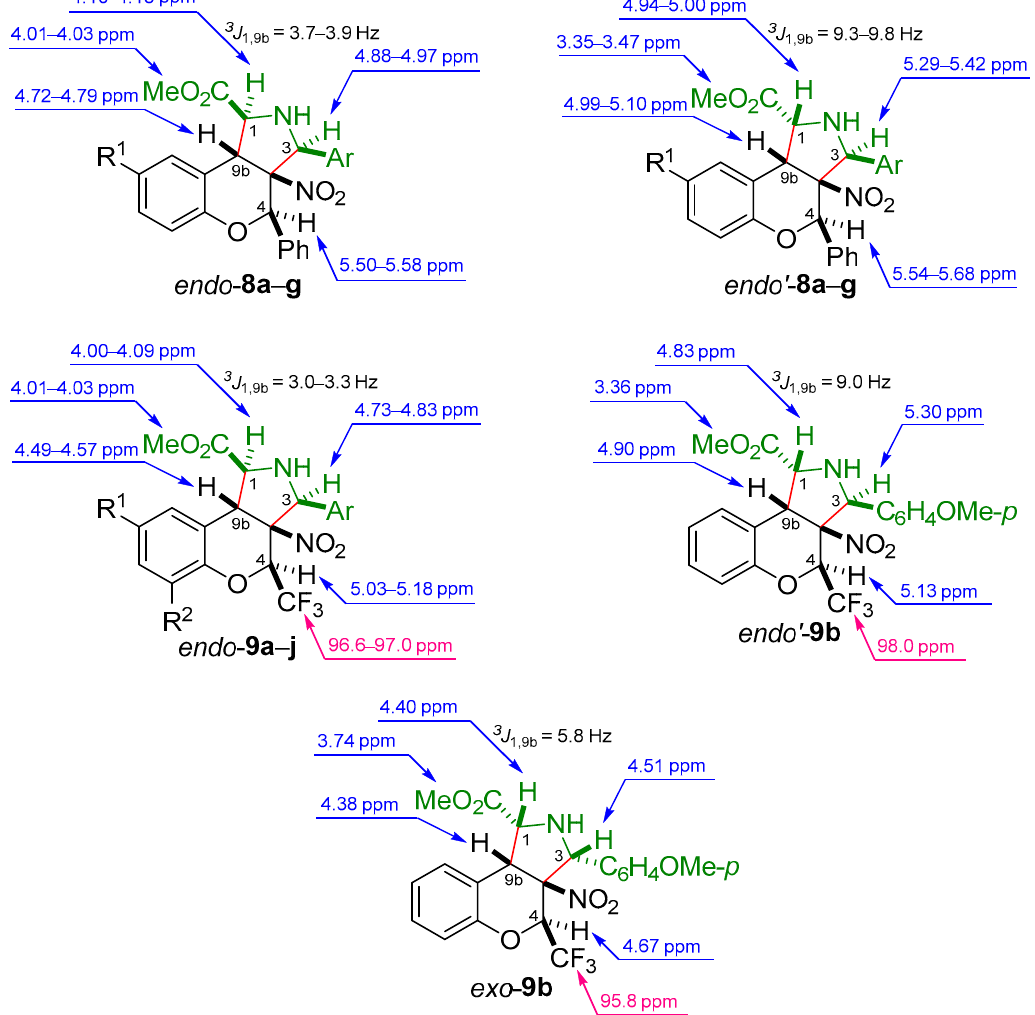
Figure 2. Characteristic chemical shifts of stereoisomeric chromeno[3,4- c ]pyrrolidines 8 and 9 in 1 H (in blue) and 19 F (in magenta) NMR spectra in CDCl 3 .